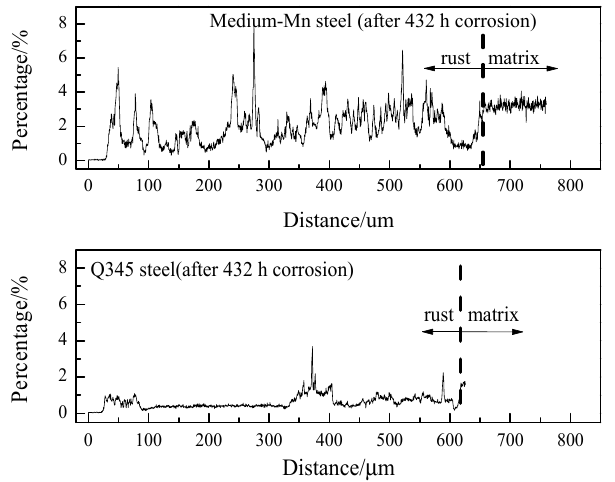
Figure 6. The typical EPMA line scanning results of Mn distribution in the rust layer of the tested medium-Mn steel and the Q345 steel after 432 h of corrosion.